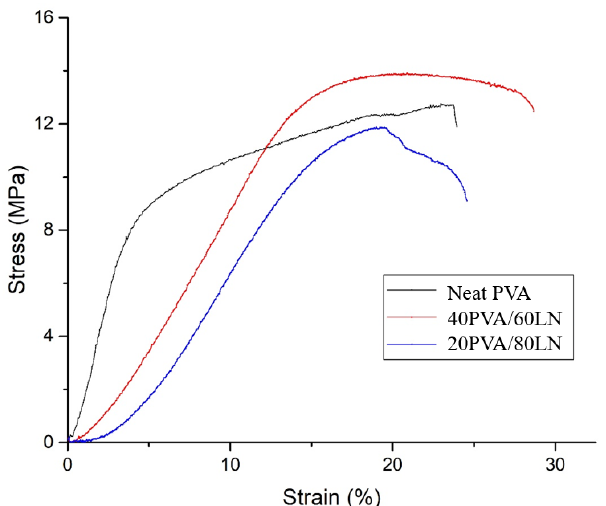
Figure 9. Young’s modulus curve of PVA and PVA/LN nanocomposite